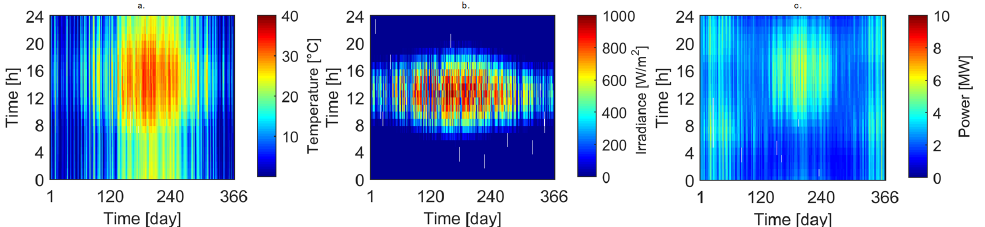
Figure 1. The 2020 experimental data for weather and total electric power for the community considered in the study. All 1810 buildings employ electric air-conditioners for cooling during the summer, but only 53% of them are using electric heat pumps for heating during the winter. ( a ) Time, ( b ) Temperature, ( c )